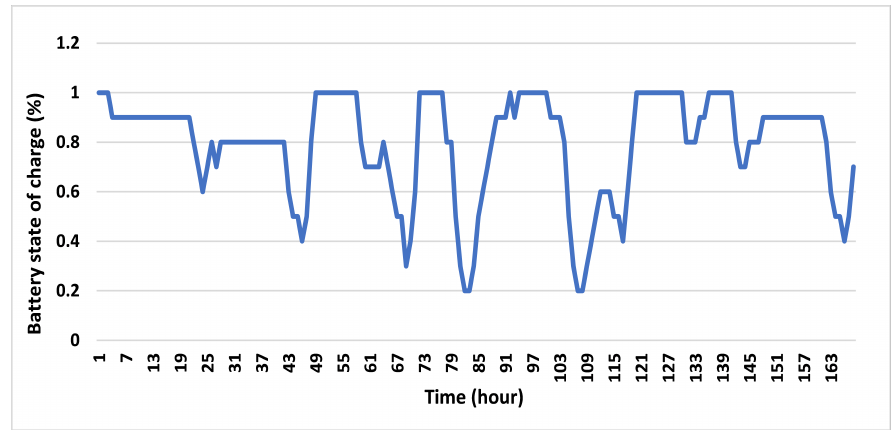
Figure 15. Battery state of charge during a week in the rainy season: Case 2.